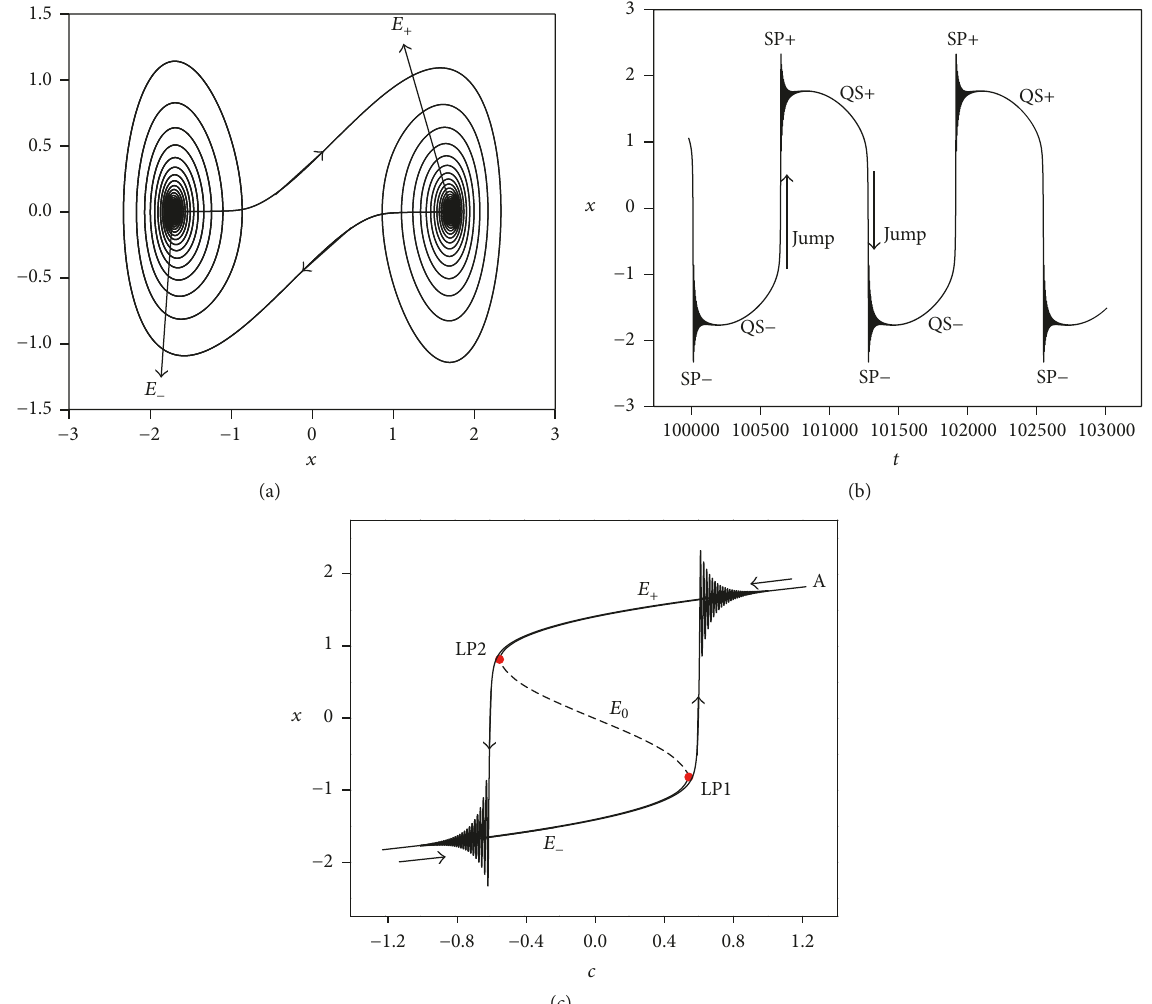
Figure 6: Bursting oscillation for 𝐴 = 1.0 . (a) Phase portrait on the (𝑥,𝑦) plane; (b) time history; (c) transformed phase portrait on the (𝑐,𝑥) plane with equilibrium